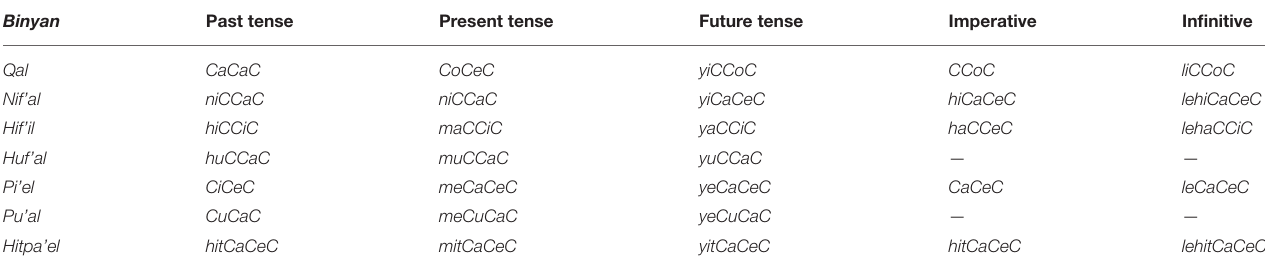
TABLE 1 | The seven binyan conjugations as sets of temporal patterns. Binyan